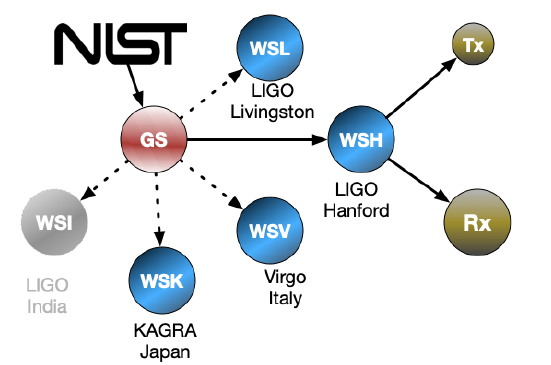
Figure 3. Schematic diagram showing the transfer of laser power calibration from NIST to the Pcal receiver (Rx) and transmitter (Tx) module power sensors (Rx and Tx) at the observatory end stations via a single Gold Standard (GS) and Working Standards (WSi) at each observatory. The Virgo, KAGRA and two LIGO detectors were actively involved in this scheme during the O3 observing run. LIGO India was expected to participate as soon as it became operational. Adapted from